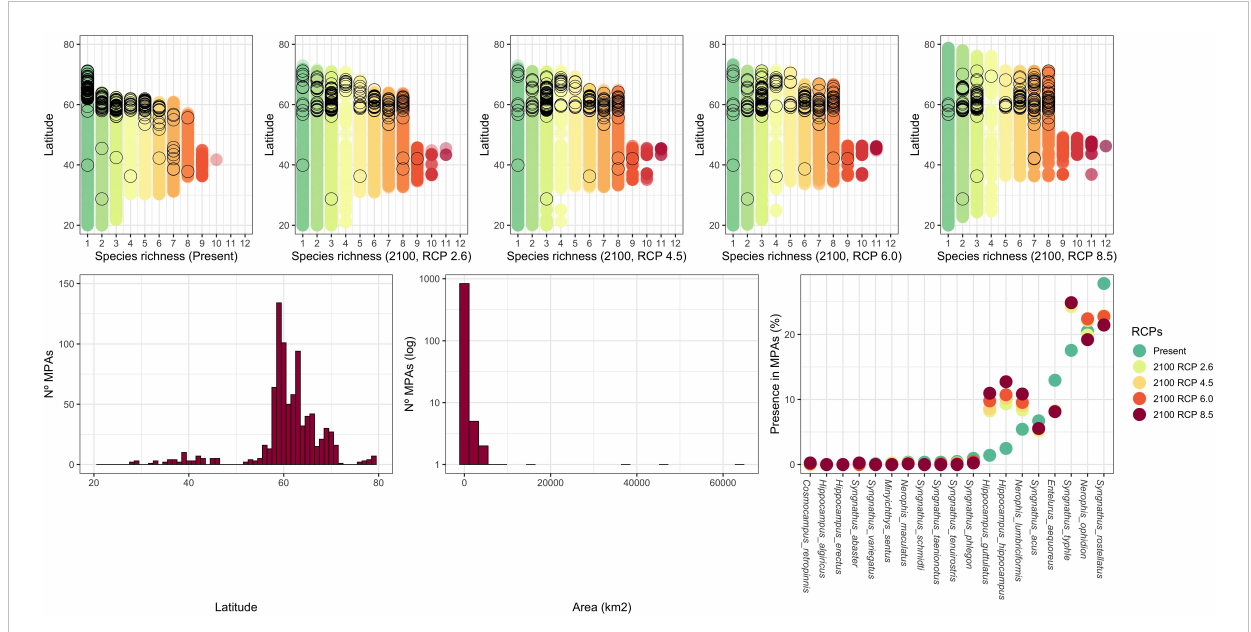
FIGURE 4 Latitudinal distribution of ‘ no-take ’ MPAs (black open circles), highlighting the number of sympatric syngnathid species, at the present and in all four considered RCP scenarios for the 2090-2100 time period (top row graphs). Latitudinal distribution of all ‘ no-take ’ MPAs (bottom left), their area distribution (histogram, log Y axis, bottom centre), and the percentage of ‘ no-take ’ MPAs where each of the nineteen European syngnathids is currently found or could potentially be found in the 2090-2100 tine-period, according to the four selected RCP scenarios (bottom